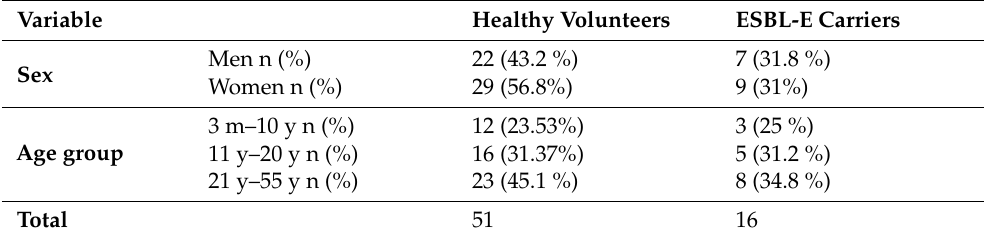
Table 1. Demographic characteristics and prevalence of ESBL-E carriage in the study population.